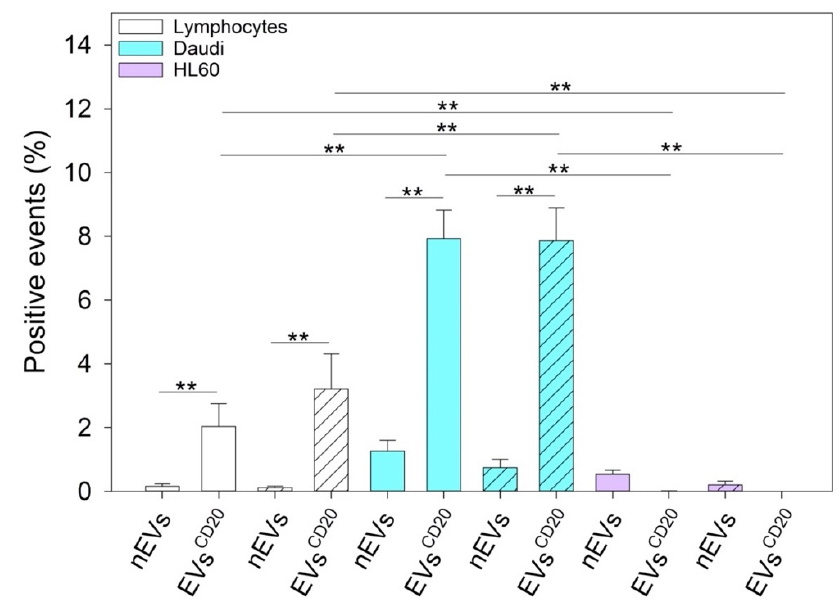
Figure 8. The graph represents the average and the SE of the results of targeted lymphocyte-derived EV uptake in lymphocytes, Daudi, and HL60 cell lines at a 5 µg/mL concentration at 24 (solid color bars) and 48 (dashed bars) hours. The table shows the resumed three-way ANOVA analysis of the results; ** p < 0.001. Independent experiments were performed three times.